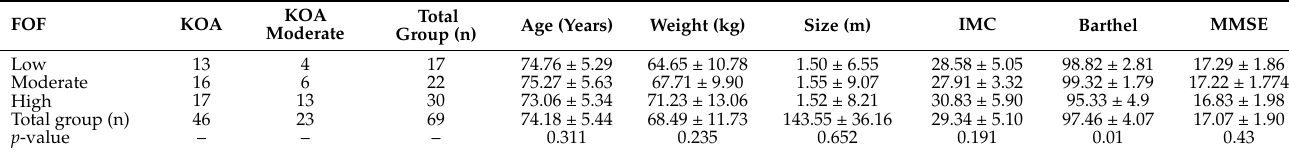
Table 1. Sample characteristics.